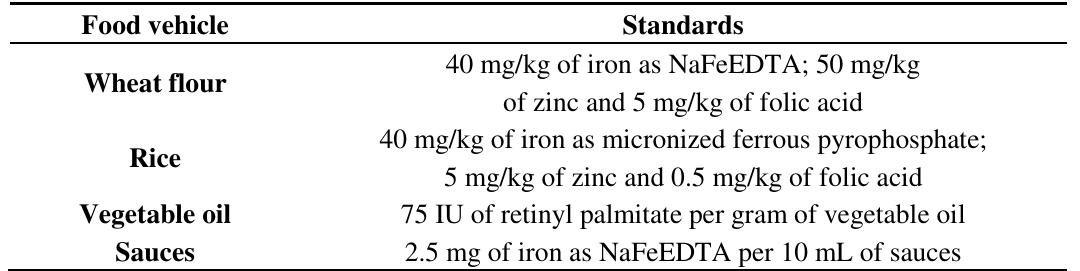
Table 1. Standards used for modeling purposes of an integrated large-scale fortification strategy in